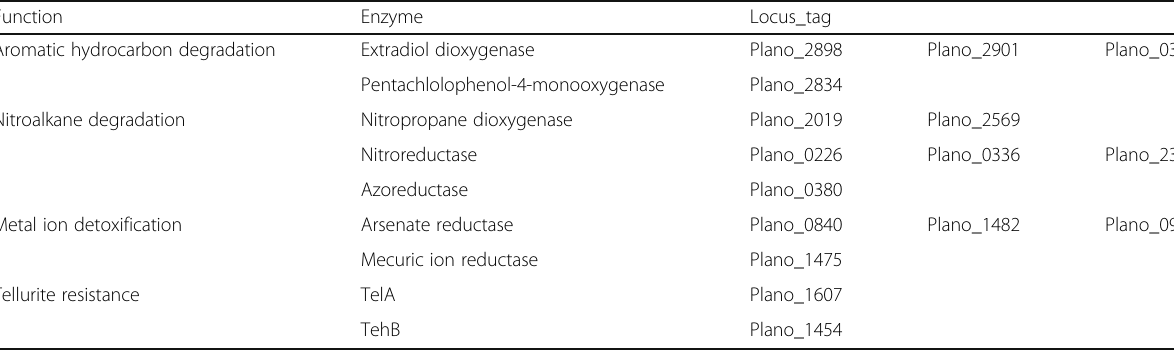
Table 5 Identified bioremediation associated genes in PAMC21323 Function Enzyme Locus_tag Aromatic hydrocarbon degradation Extradiol dioxygenase Plano_2898 Plano_2901 Plano_0315 Pentachlolophenol-4-monooxygenase Plano_2834 Nitroalkane degradation Nitropropane dioxygenase Plano_2019 Nitroreductase Azoreductase Plano_0380 Metal ion detoxification Arsenate reductase Mecuric ion reductase Tellurite resistance TelA